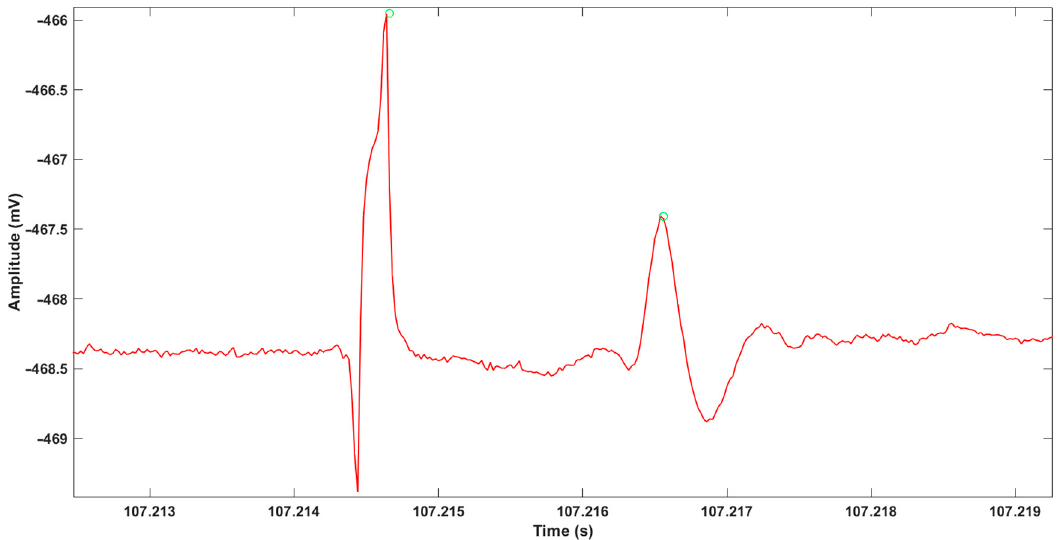
Figure 13. Variation in biopotential at the level of the spinal cord (mV: millivolt; s: second).